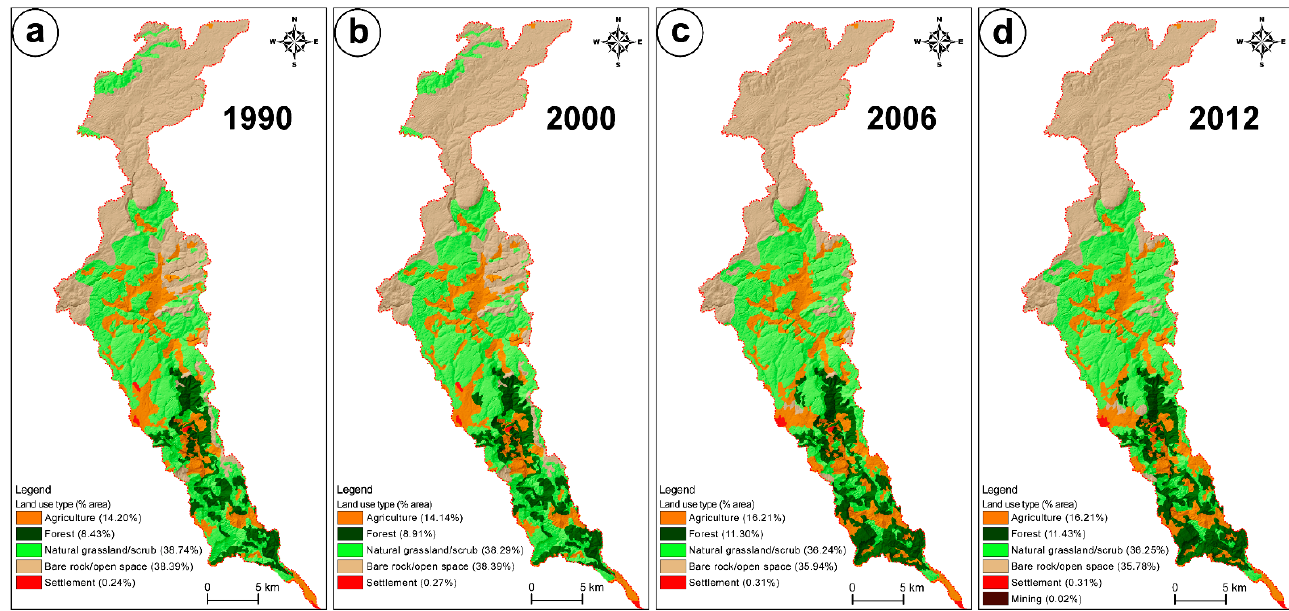
Figure 3. Major land-use classes and their percentage shares (in parentheses) of the Alata River Basin (ARB) for the years ( a ) 1990; ( b ) 2000; ( c ) 2006; and ( d ) 2012 (modified from [58,59] ).